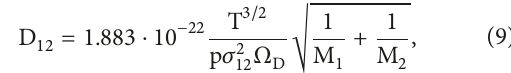
The Debye length 𝜆 D is calculated as the ratio of a sample thickness, d with the dimension-less, 𝛿